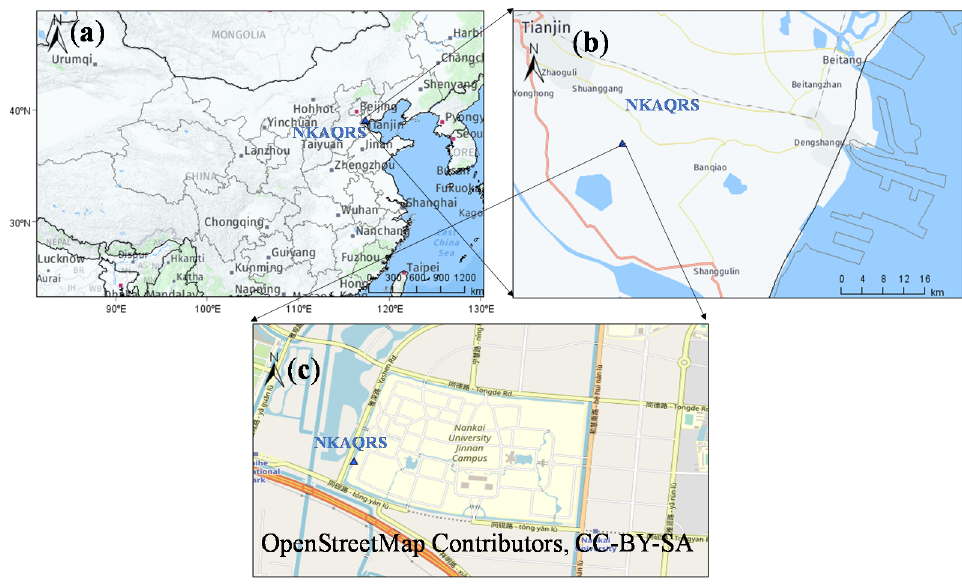
Figure 1. Map of monitoring site in Tianjin. ( a ) Geographical location of Tianjin city ( b ) Geographical location of Nankai University Air Quality research Supersite( c ) Map of Nankai University.